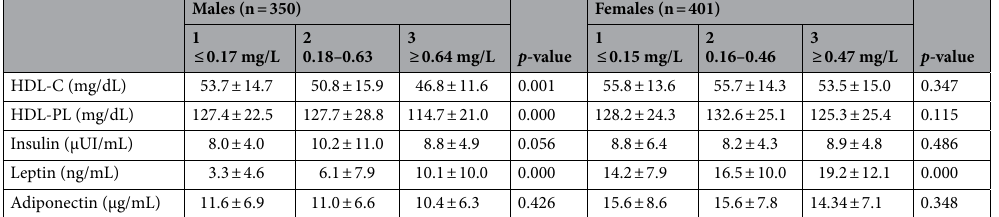
Table 2. HDL-cholesterol, HDL-phospholipid, insulin, leptin, and adiponectin concentrations (mean ± SD) by hs-CRP tertile and